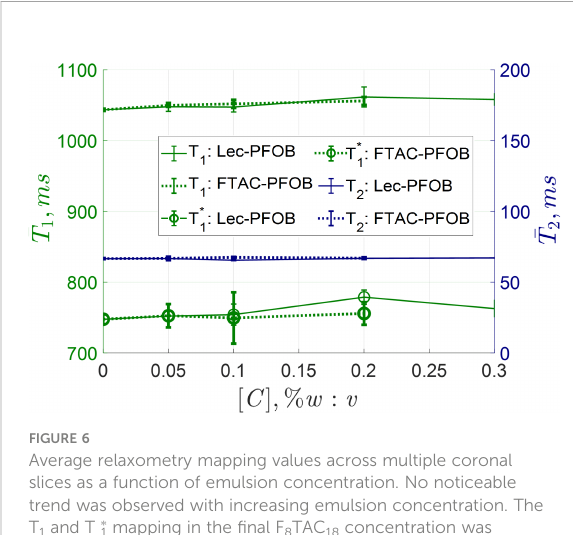
FIGURE 6 Average relaxometry mapping values across multiple coronal slices as a function of emulsion concentration. No noticeable trend was observed with increasing emulsion concentration. The T 1 and T ∗ 1 mapping in the fi nal F 8 TAC 18 concentration was removed as the sample appeared to have possibly experienced cavitation during hydrophone recordings.